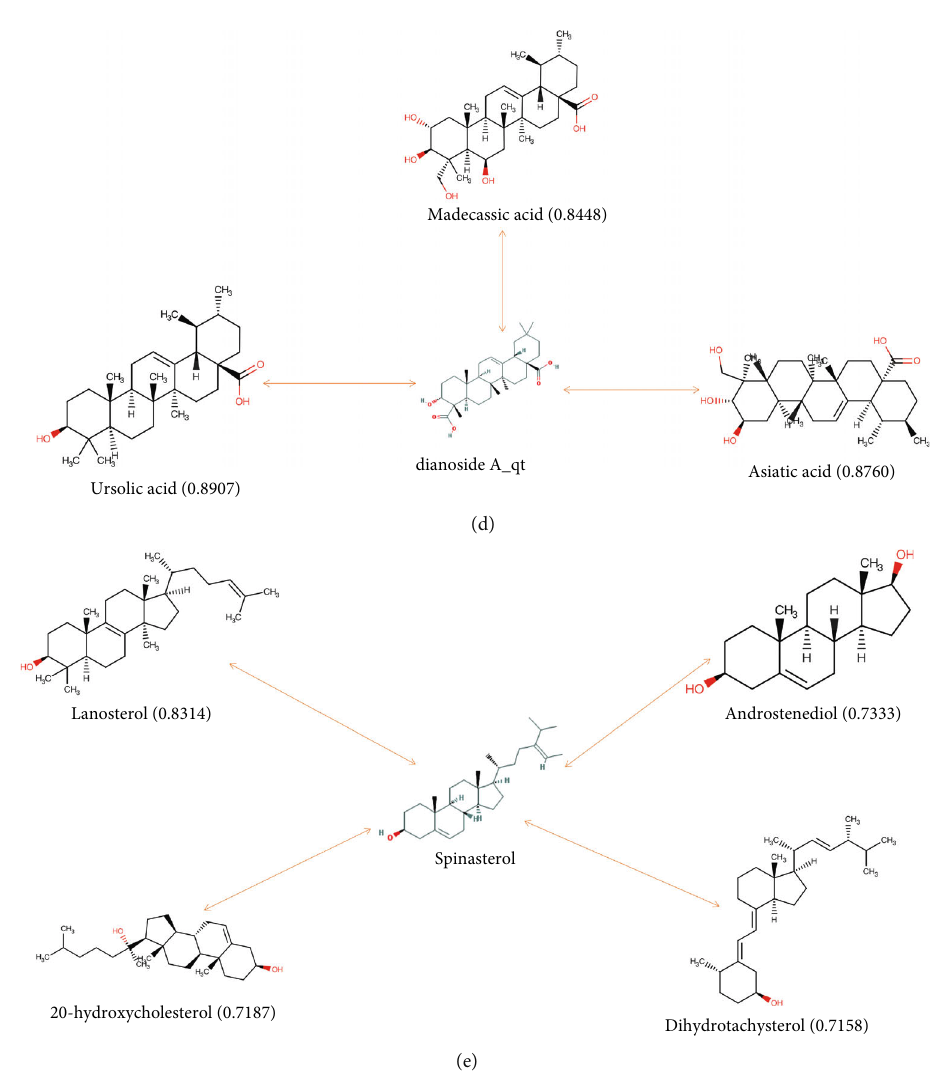
Figure 11: Drug similarity between compounds and drugs of DrugBank. The two-way line represents the comparative relationship between the compound and the drug, and the numbers represent the drug similarity. (a) drug similarity of (-)-taxifolin; (b) drug similarity of isofucosterol; (c) drug similarity of 11,14-eicosadienoic acid; (d) drug similarity of dianoside A_qt; (e) drug similarity of